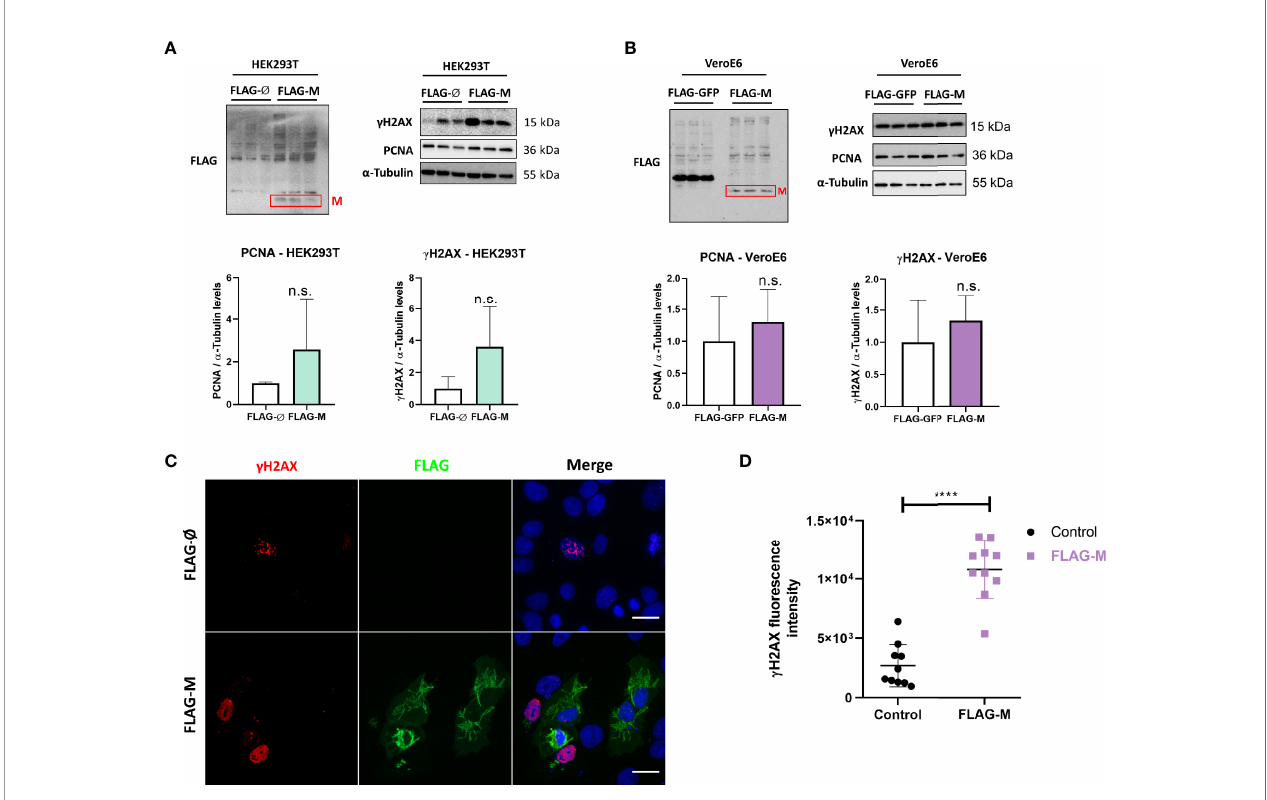
FIGURE 4 | PCNA and g H2AX levels in transfected cell lines. (A) Detection of PCNA and g H2AX levels in HEK293T cells transfected with pFLAG-M compared to pFLAG (empty vector). (B) Detection of PCNA and g H2AX levels in Vero E6 cells transfected with pFLAG-M compared to pFLAG-GFP. Graphs show a slight increase in normalized protein levels; however, the statistical test does not show signi fi cance. Western blotting data in (A, B) are representative of one independent experiment. (C) Immuno fl uorescent staining of FLAG-M (green) and g H2AX (red) in Vero E6 cells 24 hours post-transfection. Images are representative of two independent experiments. Scale bar 20 m m. (D) Fluorescence intensity quanti fi cation of g H2AX levels in FLAG-M transfected versus non-transfected cells. Fluorescence intensities in the nucleus were measured as described in Figure 2B . Data represent mean ± SD in samples from 2 independent experiments (n = 10). For statistical analysis, a two-tailed unpaired T-test was conducted. n.s, non-signi fi cant, ****p < 0.0001 was considered statistically signi fi